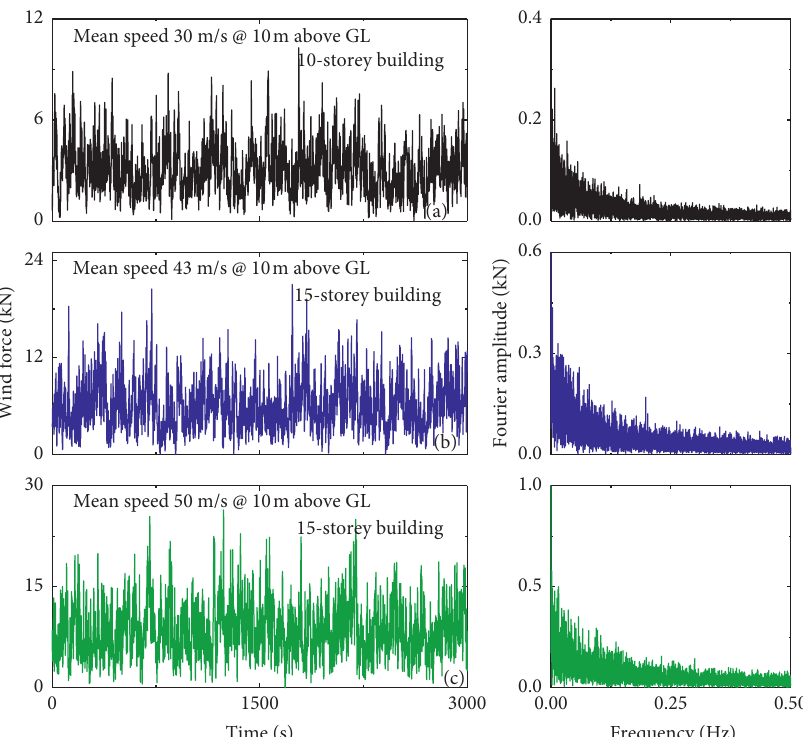
Figure 5: Wind speed at specific height for 10- and 15-storey buildings along with the frequency content (FFT spectra). Table 5: Combinations of dynamically similar and dissimilar connected buildings considered for the study. Similar